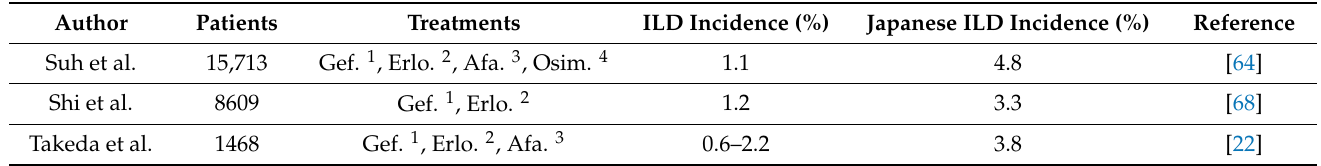
Table 2. Incidence of interstitial lung disease (ILD) on EGFR-TKI treatment in meta-analysis.